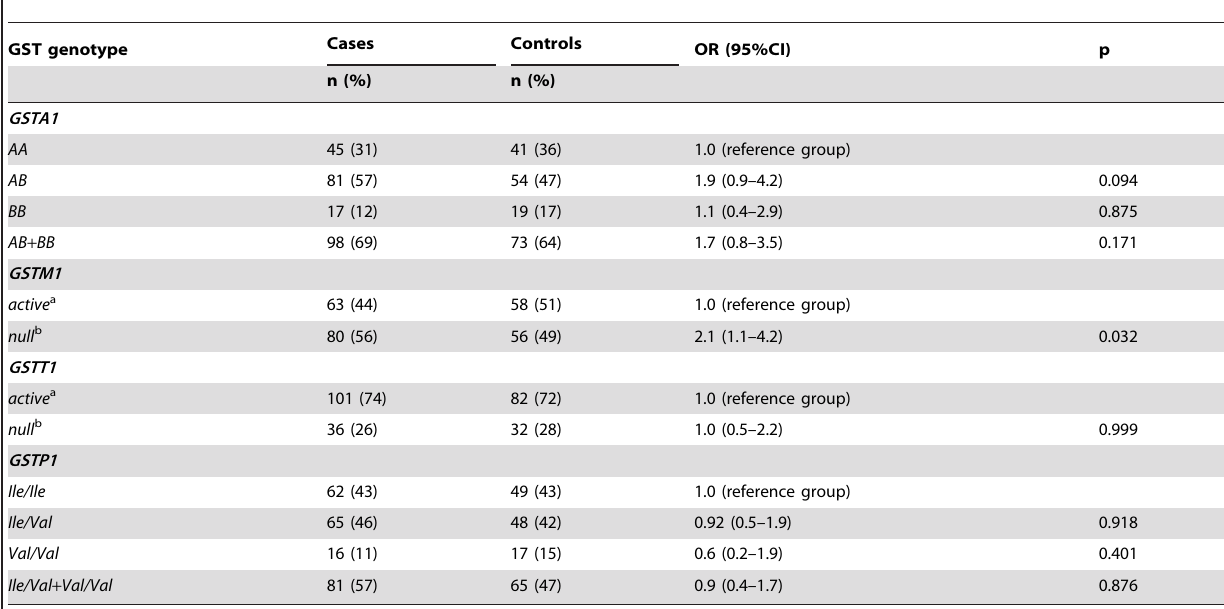
Table 2. GSTA1, GSTM1, GSTT1 and GSTP1 genotypes in relation to bladder cancer risk in male